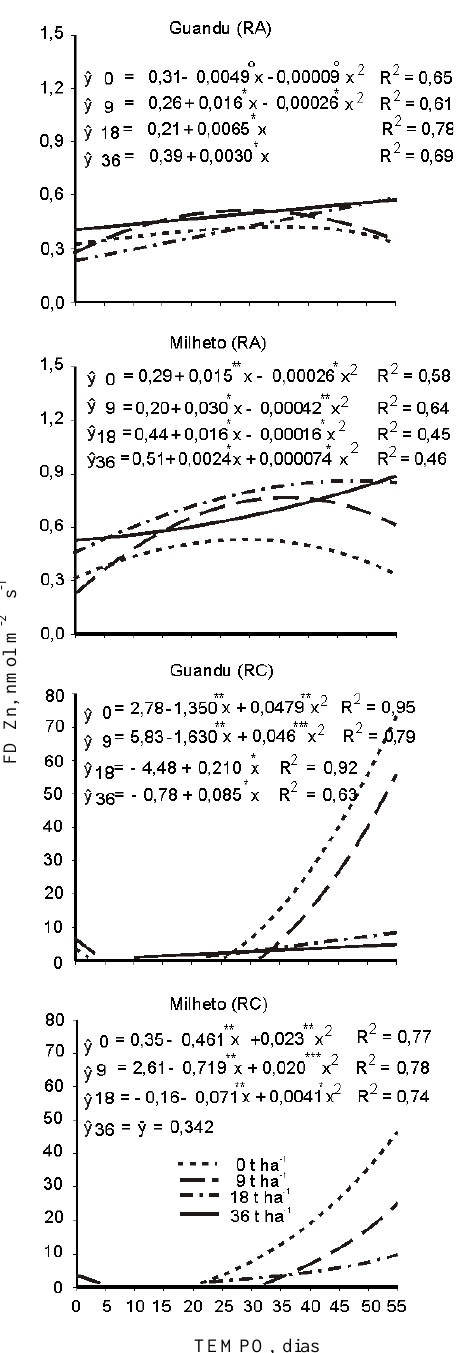
Figura 1. Fluxo difusivo de Zn para as resinas: aniônica (RA) e catiônica (RC), em Latossolo Vermelho argiloso influenciado pelo tempo de incubação e doses de feijão guandu e milheto. ns , º , * , ** , *** : não-significativo e significativos a 10, 5, 1 e 0,1 %,